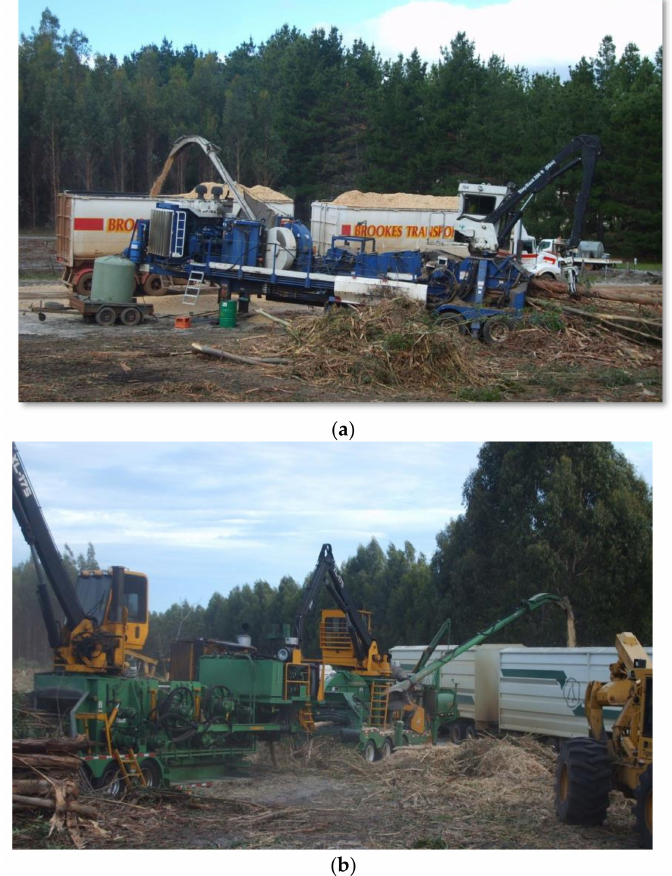
Figure 1. The two machine types at work: integrated ( a ) and combination ( b